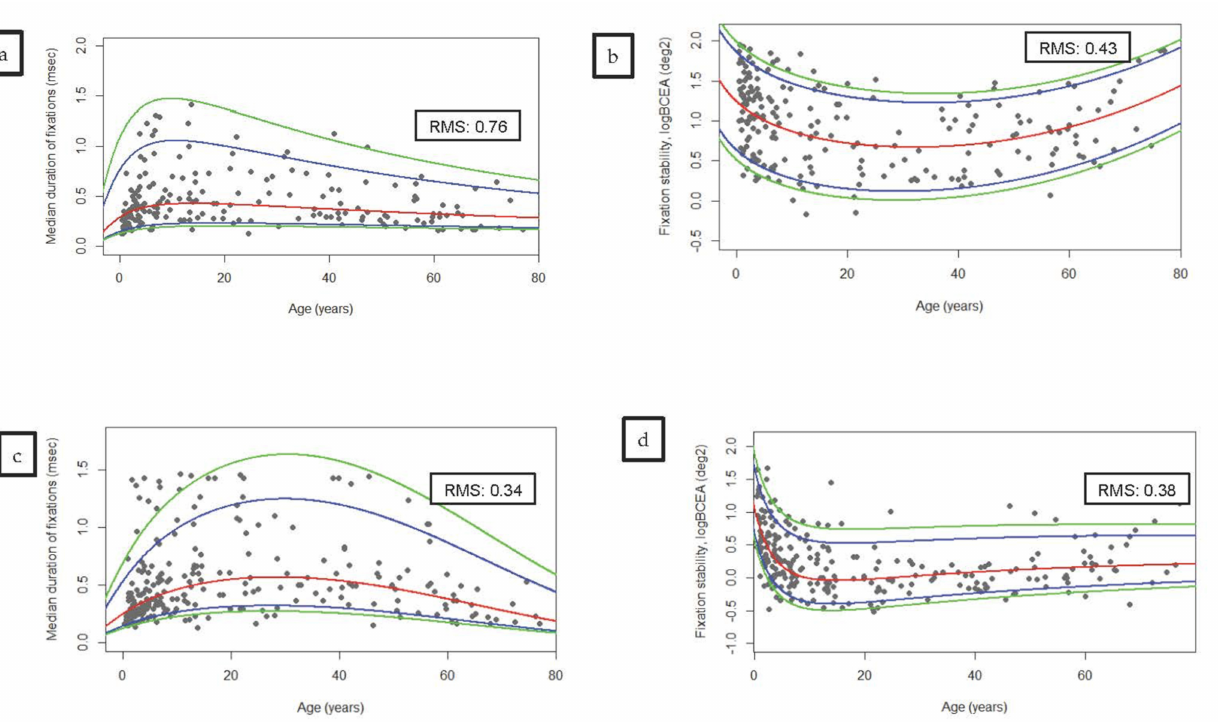
Figure 3. Scatterplots representing ( a ) median duration of fixation with long fixational task, ( b ) fix- ation stability with long fixational task, ( c ) median duration of fixation with short fixational task, ( d ) fixation stability with short fixational task, outcomes plotted against age. Legend: From bottom to top, the first green line corresponds to P05, the blue one to P10, the red line corresponds to the one that best fits the model (P50), the second blue line to the P90, and the second green line to